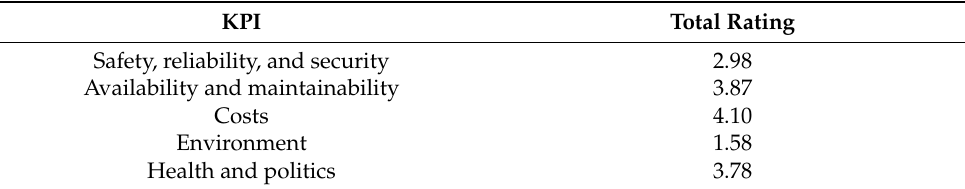
Figure 8. Spider diagram of all KPI rates. Table 13. Assessment of the key performance indicators (KPIs) for the case study